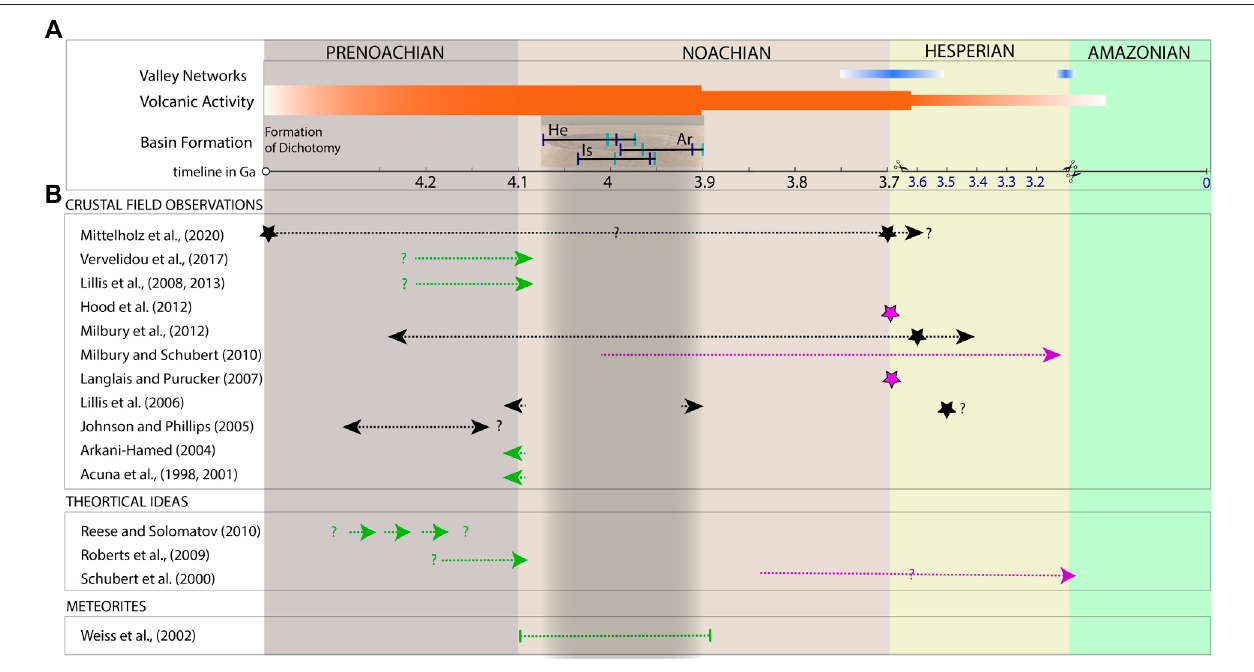
FIGURE 5 | (A) A summary timeline for major relevant volcanic, fl uvial activity and basin formation events on Mars and (B) literature addressing dynamo timing: (A) Errorbarsrepresentisochron(cyan)andN(50)(blue)ageestimates(Robbinsetal.,2013)forHellas(He),Isidis(Is)andArgyre(Ar)andthegreyshadedareain (A) and (B) highlights the maximum time interval over which basin forming events occurred according to those estimates. (B) Stars represent magnetized features that suggest an active dynamo at a speci fi c time. Arrows indicate “ later/earlier than ” arguments and “ ? ” refer to unknown starting/end points. Purple/green arrows/stars indicate studies that have been used to argue for an early/late dynamo. Black arrows indicate studies that have not been used to argue for either late or